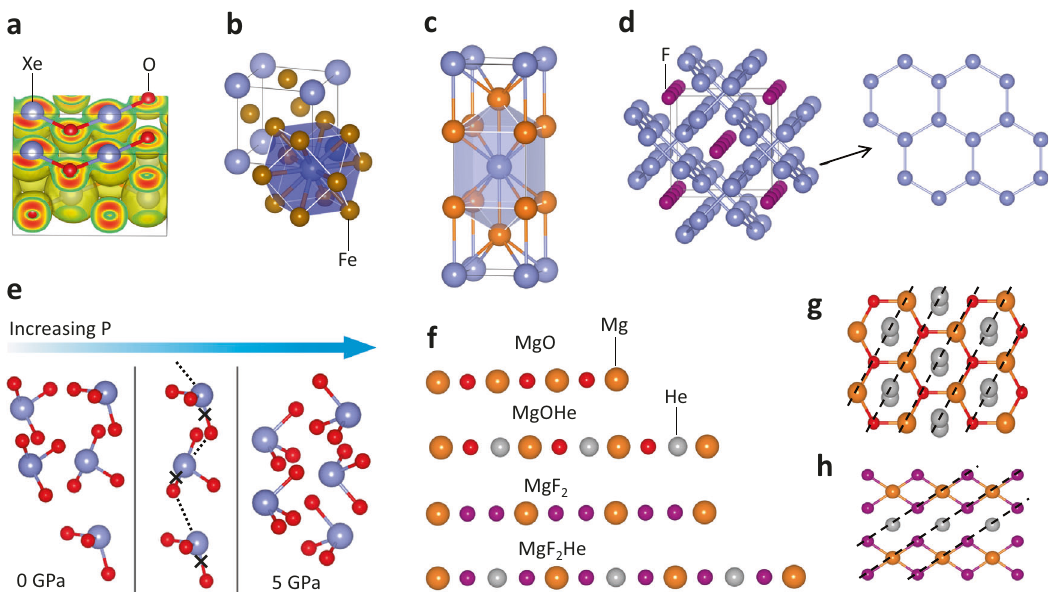
Fig. 1 Stable structures with noble gas elements acting as cations, anions, and insertions. a Electron localization function of XeO in Pbcm structure, showing Xe-O chains connected by strong Xe-O covalent bonds. b P (cid:1) 62 m structure of XeFe 3 , with Xe atom located at the center of XeFe 12 tetrakaidecahedron. c I4/mmm structure of Mg 2 Xe. d I4/mcm structure of Xe 2 F, in which the Xe atoms form graphene-like Xe monolayers with strong Xe- Xe bonds. e The migration path of O via noble gas bond in the transition from low-pressure phase to high-pressure phase of XeO 3 . f Schematic diagram of different types of He insertion in AB-type (MgO) and AB 2 -type (MgF 2 ) compounds. g (001) plane of MgOHe, the He dimers locate out of the Mg-O chains (black dash lines) to avoid the increasing of electrostatic Madelung energy. h (110) plane of MgF 2 He, the He atoms locate between two F atoms on the F-Mg-F chains (black dashed lines) to reduce the electrostatic Madelung